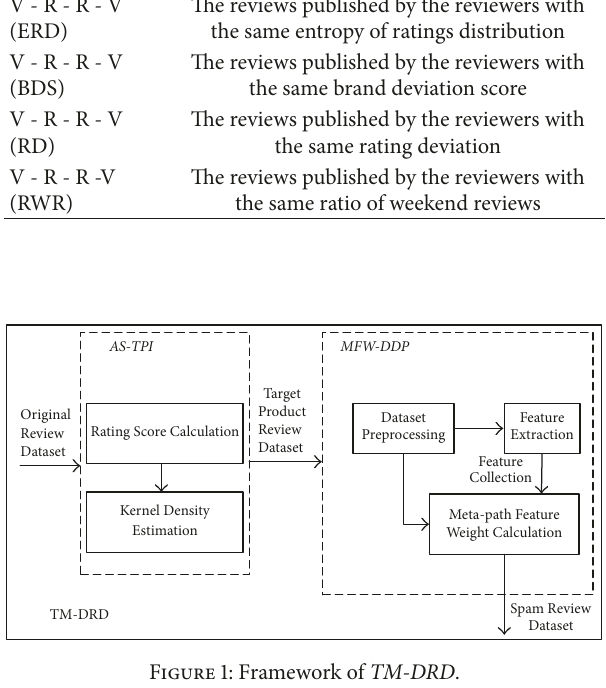
Algorithm 2 is named as DynamicTargetProduct-Detec- tion . In Algorithm 2, review sequence and other